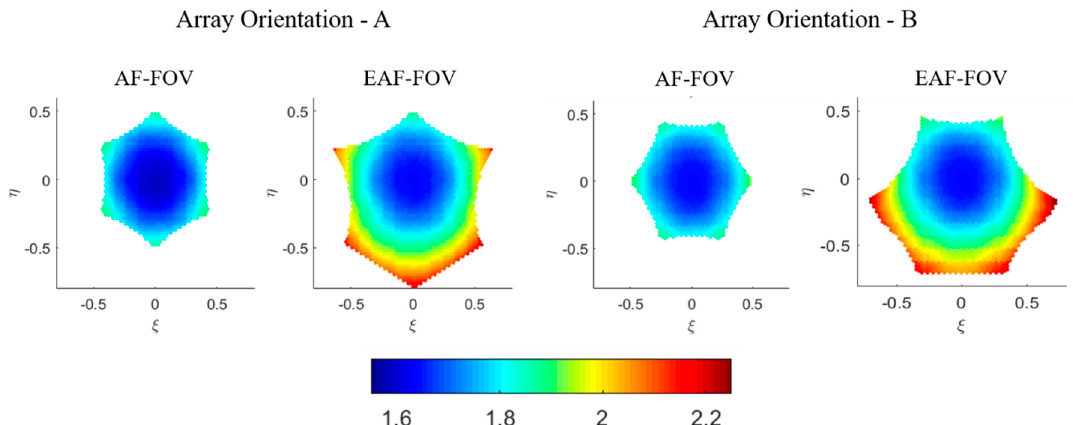
Figure 6. Illustration of the TB radiometric resolution (radiometric sensitivity) distributions of horizontal polarization in the antenna coordinate, according to different array orientations. The distributions in the AF-FOV and EAF-FOV are shown separately. The axes are the director cosines ( 𝜉 − 𝜂 ) and the color scale is in Kelvin.